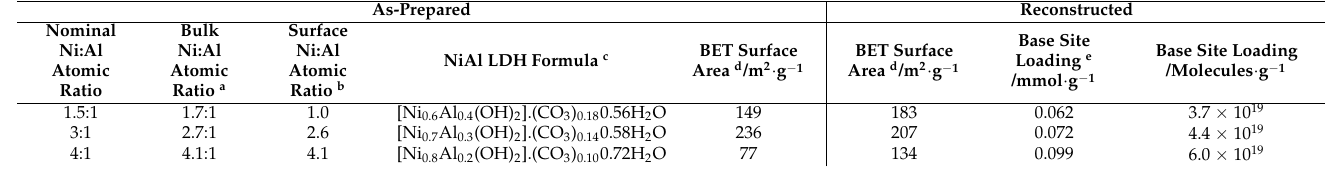
Figure 1. Powder XRD patterns of ( a ) As ‐ prepared; ( b ) Calcined; and ( c ) Hydrothermally recon ‐ structed, alkali ‐ free NiAl LDH materials. Table 1. Physicochemical properties of as ‐ prepared and reconstructed NiAl LDH materials. As ‐ Prepared